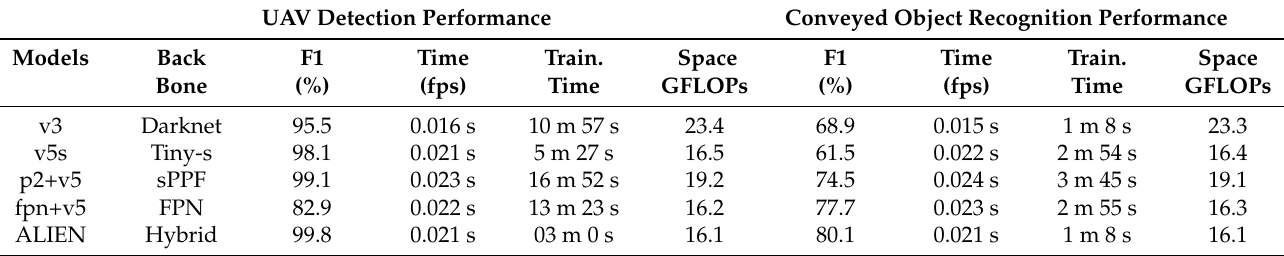
Table 7. Models performance evaluation I.